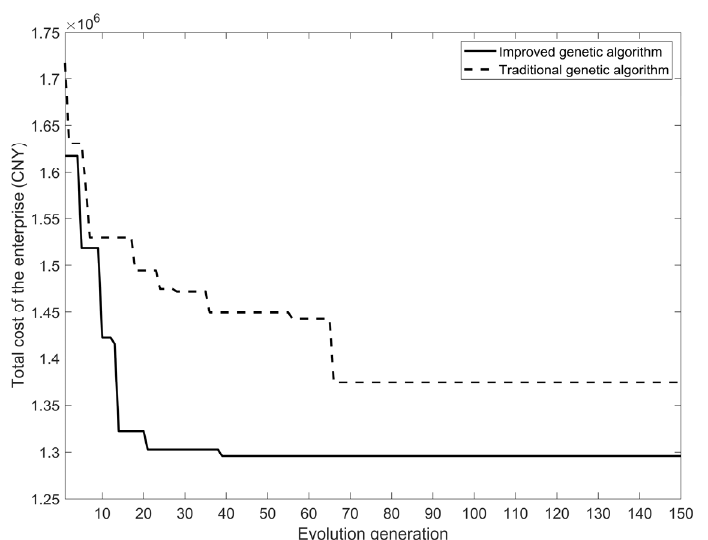
Figure 6. Sensitivity analysis of physical store service level.